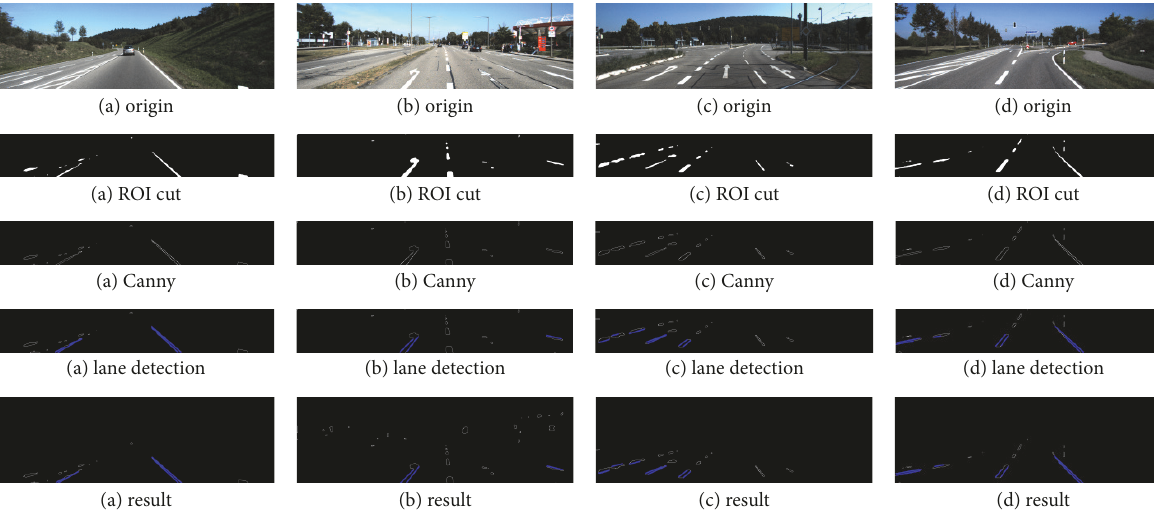
Figure 12: Lane detection using Hough of sample frames (a), (b), (c), and